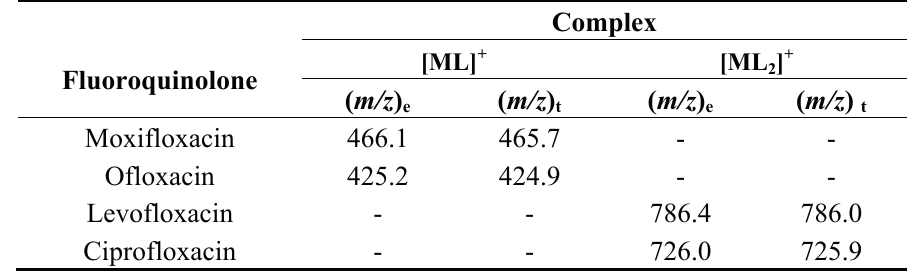
Table 8. Experimental and theoretical m/z values of ESI-MS spectra in Nickel-fluoroquinolone solution at pH = 4.5. Complex Fluoroquinolone